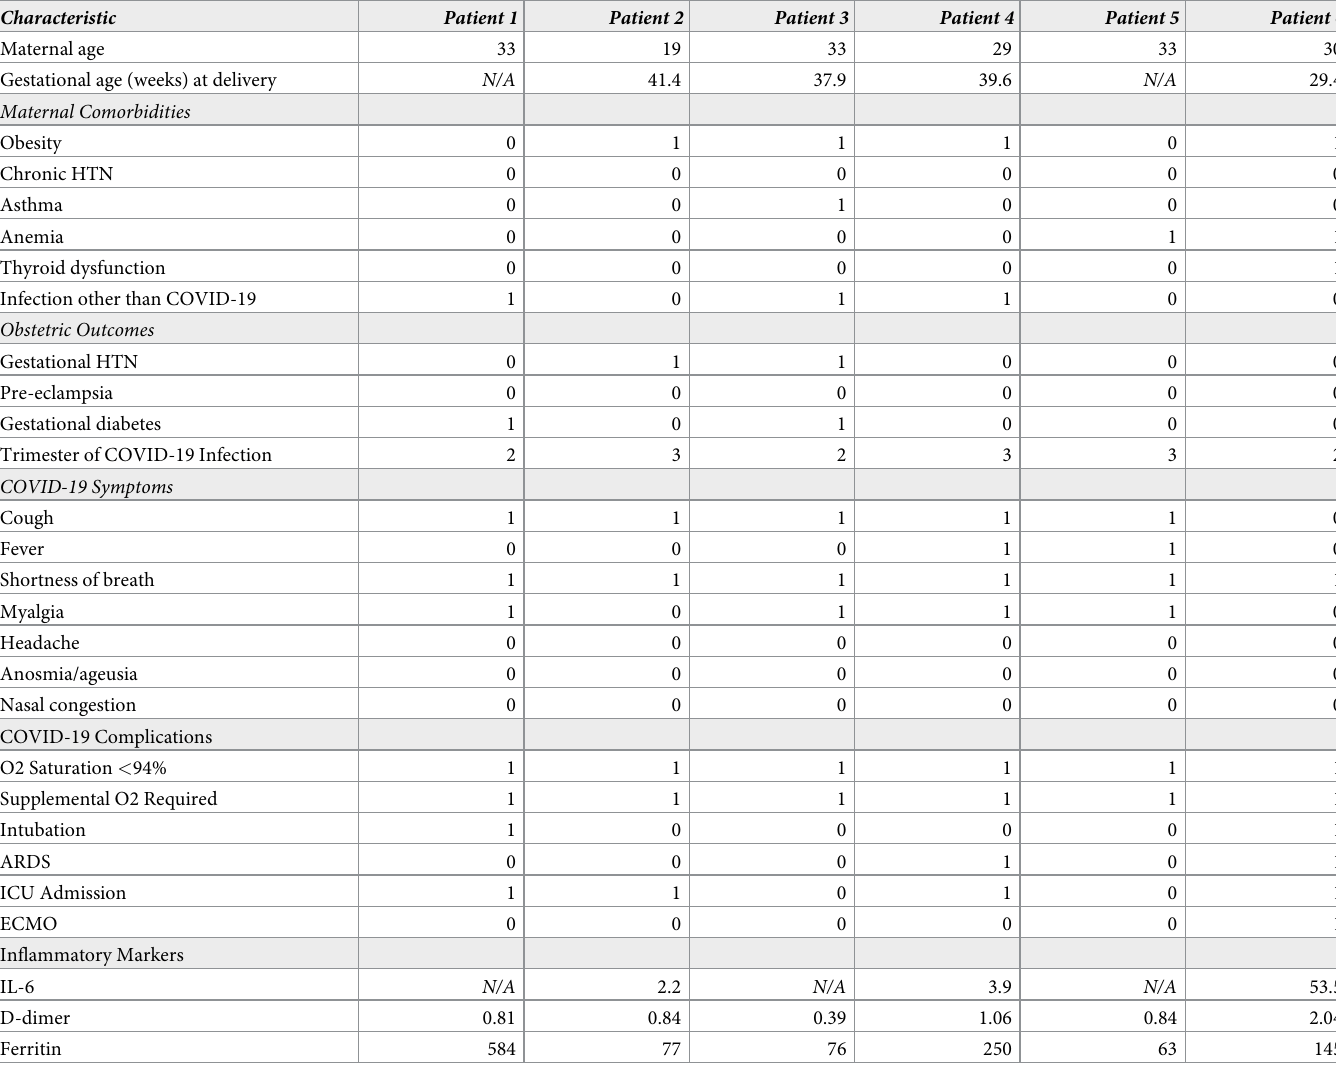
Table 2. Demographic and clinical characteristics of cohort with severe COVID-19 (n =